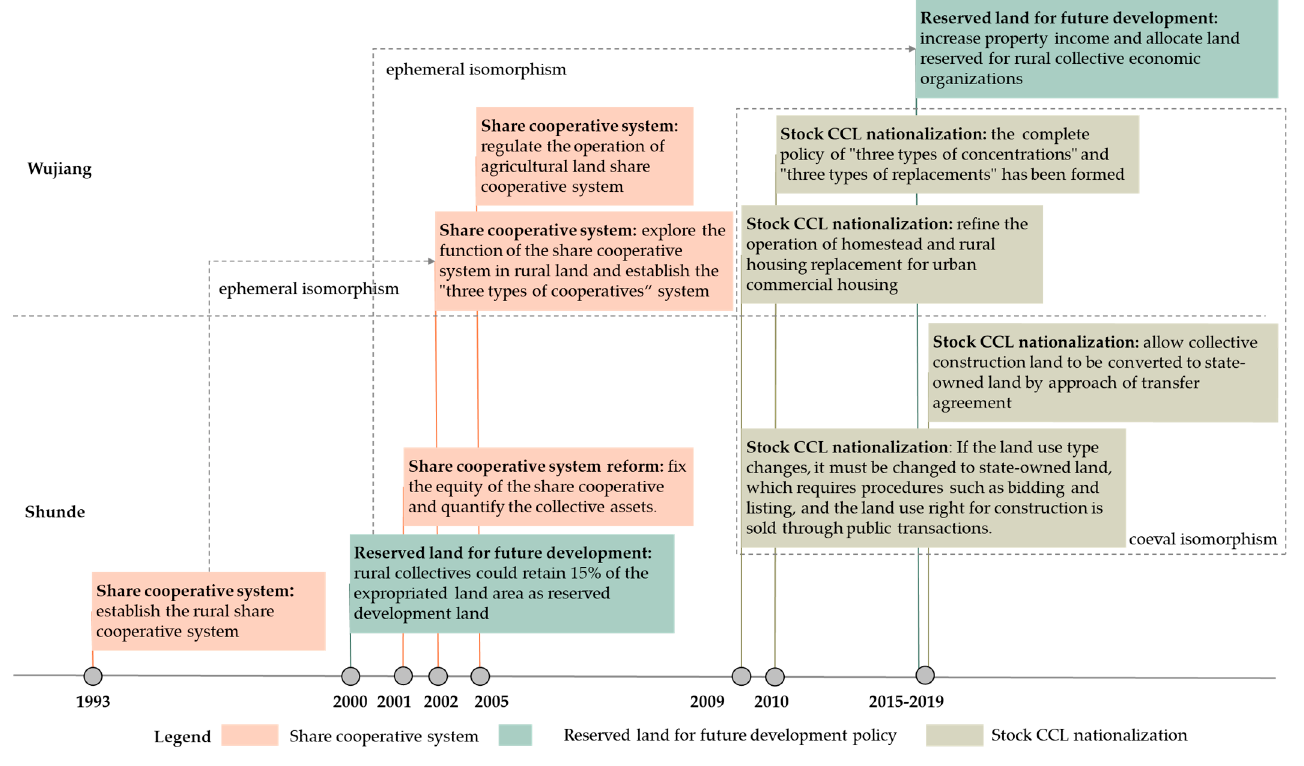
Figure 4. Changes in the collective-owned construction land system in Shunde and Wujiang since the 1990s.